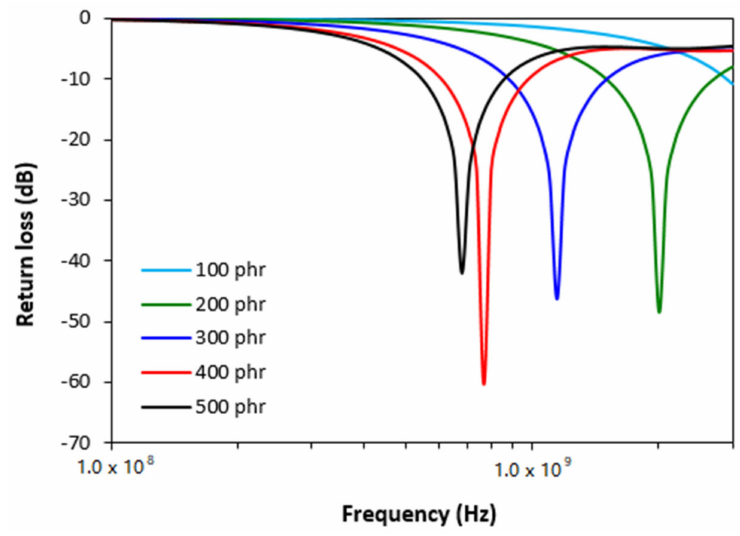
Figure 3. Frequency dependences of return loss for ferrite filled